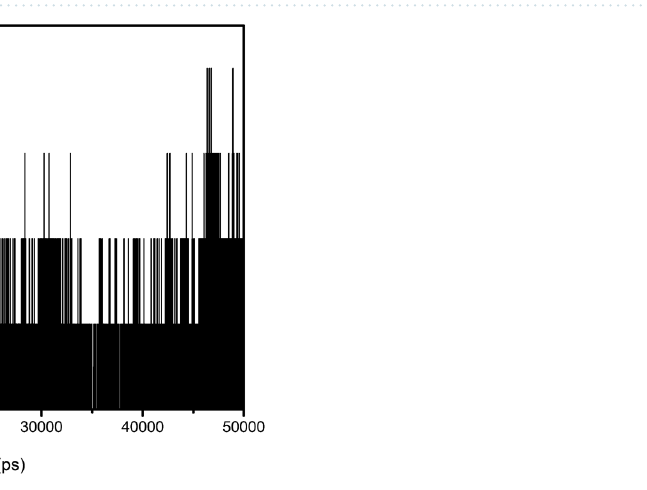
Figure 6. Changes in SASA values ( A ) and relative distribution frequency ( B ) of 8c -BChE complex.